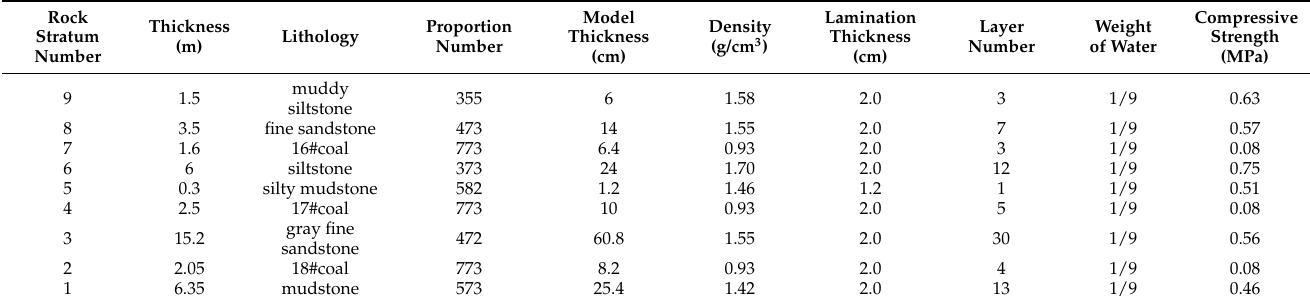
Table 1. Similar material ratio and mechanical parameters.